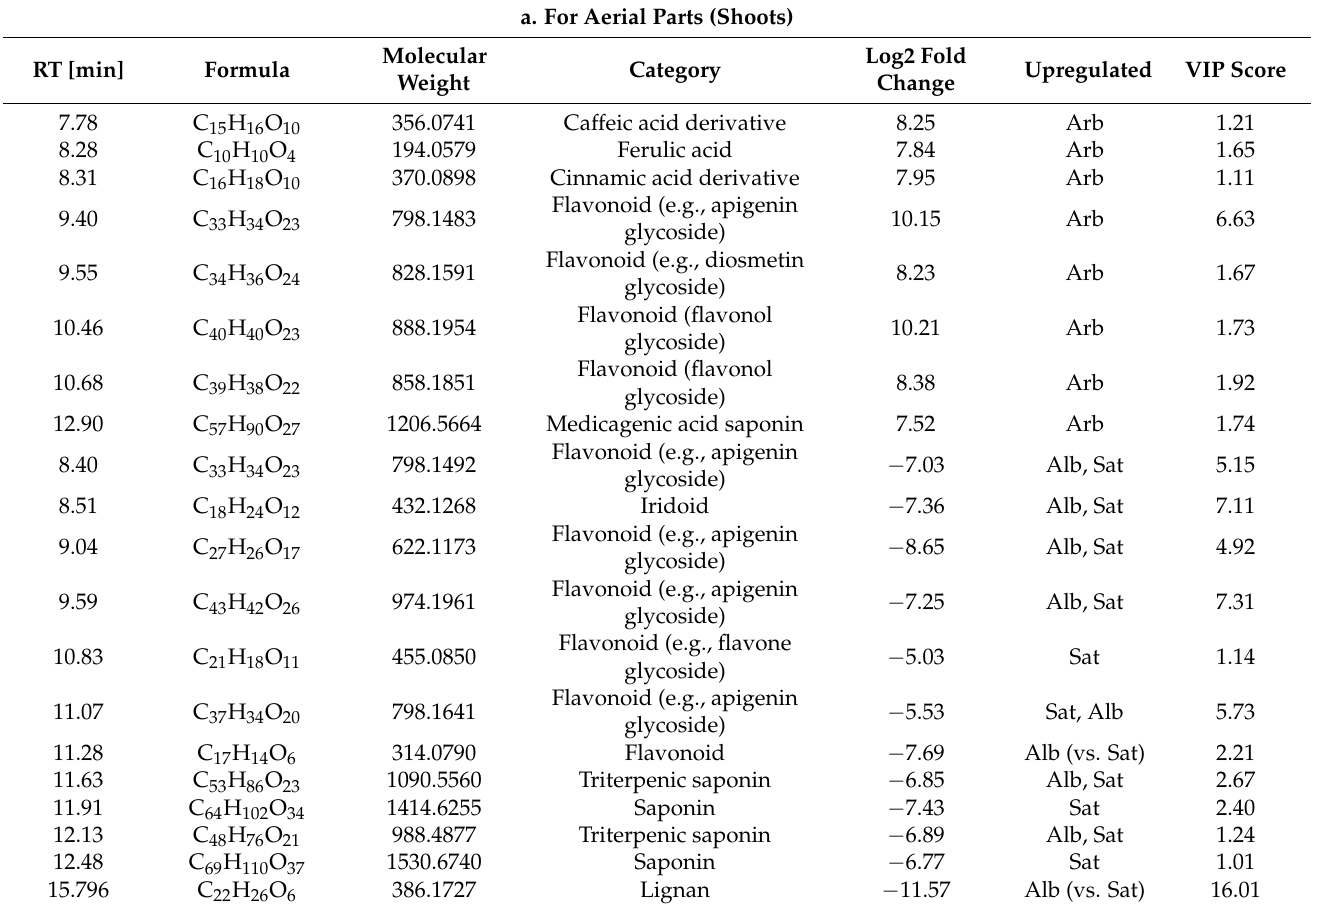
Table 3. VIP features (secondary metabolites) with their tetention times (RT), molecular weight, molecular formu- las, their tentative identification, and their statistical measurements that characterize each species subjected to acute salinity